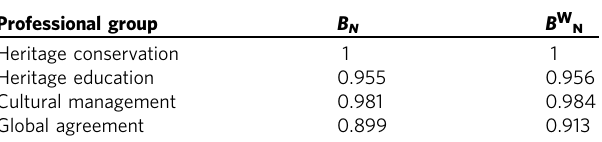
Table 7 Initial concordance coef fi cients ( B N ) and weighted ( B W N ) by dimension.